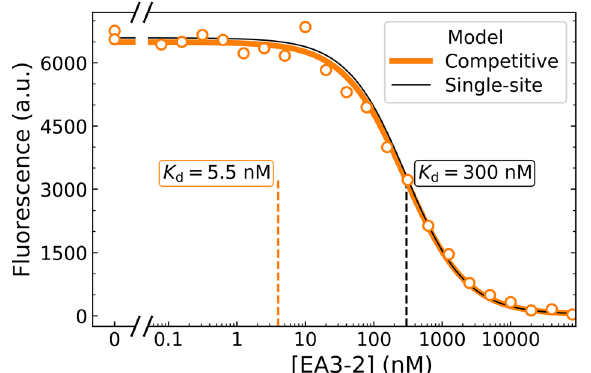
Figure 11. Determination of the binding constant of EA3-2 to CAIX expressed on live HeLa cells by competition with the fluorescein-containing GZ19-32. The concentration of GZ19-32 was constant at 10 nM while EA3-2 was dosed in two 12-step two-fold dilution series, first starting from 80 µM and the second – from 80 nM. The compounds GZ19-32 and EA3-2 were added together as a mixture. The single-site binding model would yield an uncorrected K d = 300 nM, while the competitive model yielded a corrected K d = 5.5 nM. Both models appear to fit the data well, but only the competitive model properly describes the situation.